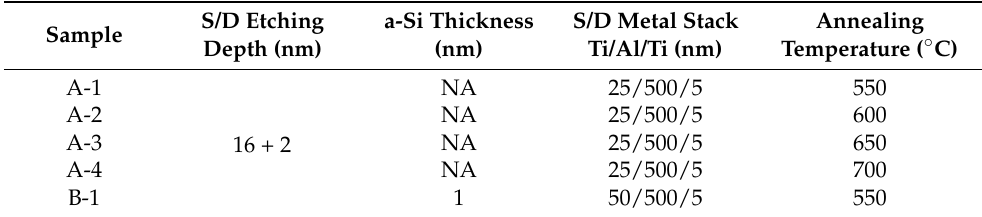
Table 1. Summary of sample list and the corresponding etching depth, a-Si thickness, S/D metal stack, and annealing